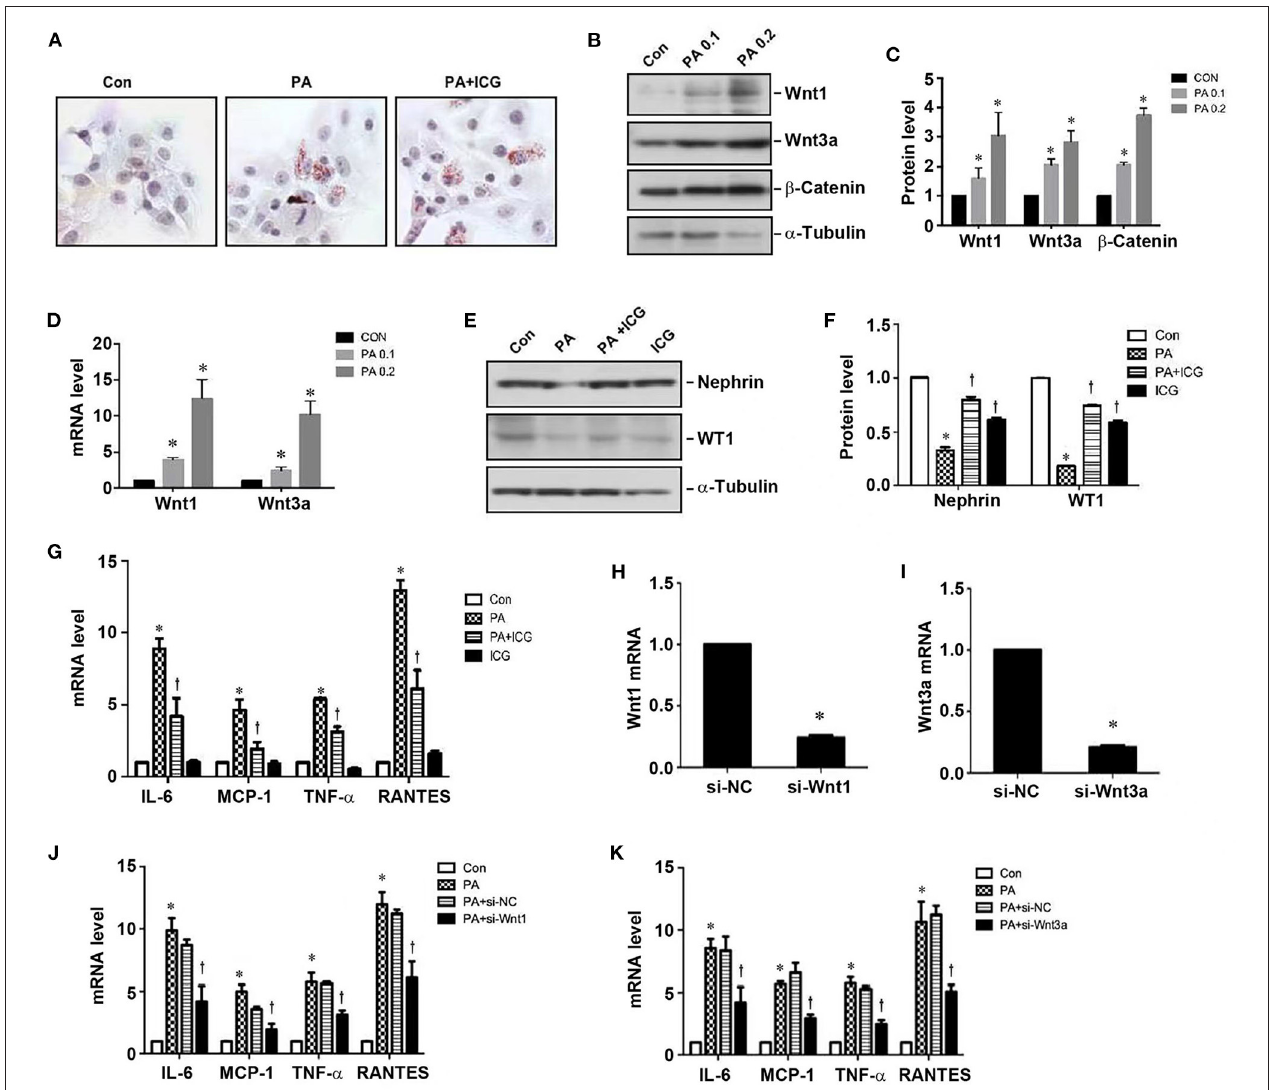
FIGURE 5 | Inhibition of Wnt/ β -catenin signaling ameliorates palmitate-induced podocyte injury. (A) Palmitate induced cellular lipid deposition in cultured podocytes, as shown by oil red staining. (B,C) Wetsern blotting show that palmitate induced protein expression of Wnt1, Wnt3a, and β -catenin in podocytes. Representative western blot (B) and quantitative data (C) are shown. (D) qRT-PCR shows that palmitate induced mRNA expression of Wnt1 and Wnt3a in podocytes. (E,F) Western blot analyses show that ICG-001 abolished PA-triggered loss of nephrin and WT1 in podocytes. (G) qRT-PCR shows that PA induced the mRNA expression of pro-inflammatory cytokines in podocytes, which was inhibited by ICG-001. (H,I) Knockdown of Wnt1 (H) and Wnt3a (I) expression by siRNA in podocytes. (J,K) qRT-PCR demonstrates that knockdown of either Wnt1 or Wnt3a inhibited the expression of various cytokines as indicated. CON, control; PA, palmitate; PA0.1: 0.1 mmol/L palmitate; PA0.2, 0.2 mmol/L palmitate; ICG, ICG-001. * P < 0.05, CON vs. PA, † P < 0.05PA vs. PA + ICG or PA + si-Wnt1/3a, n =